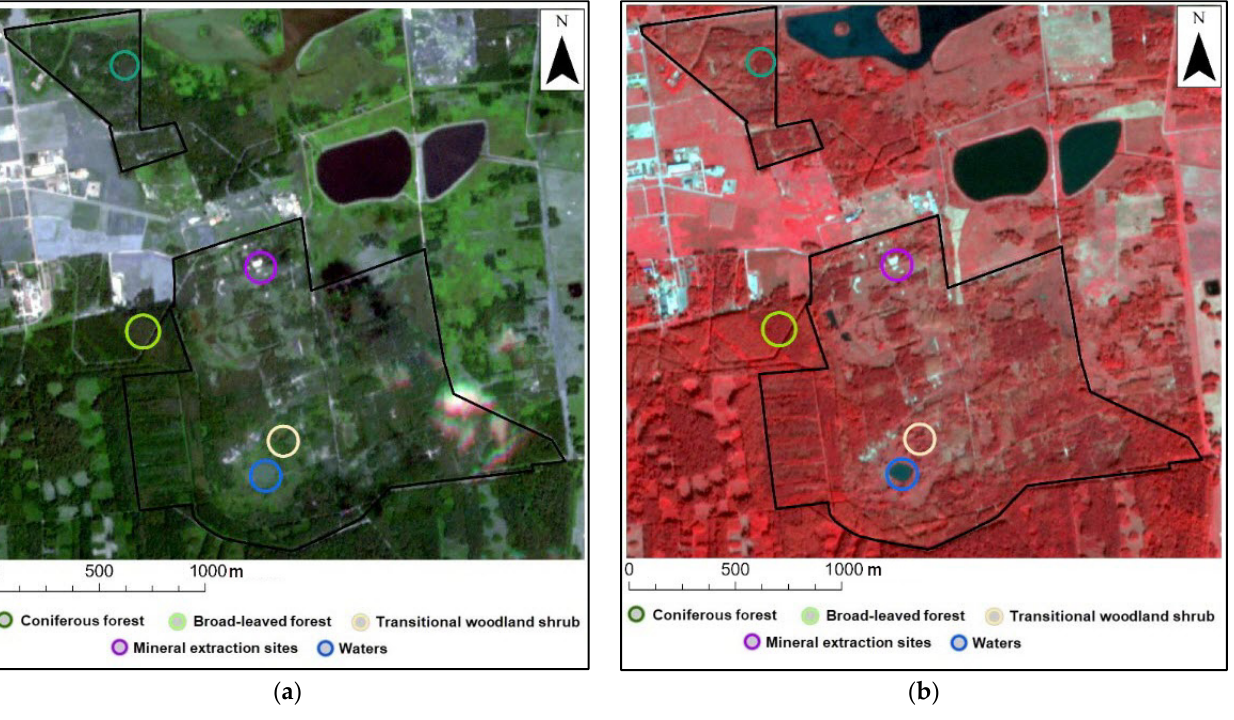
Figure 3. Examples of LULC classes for the Jeziórko former sulfur mine research area: ( a ) RGB; ( b ) CIR color composition (source: Planet imagery, 2019).